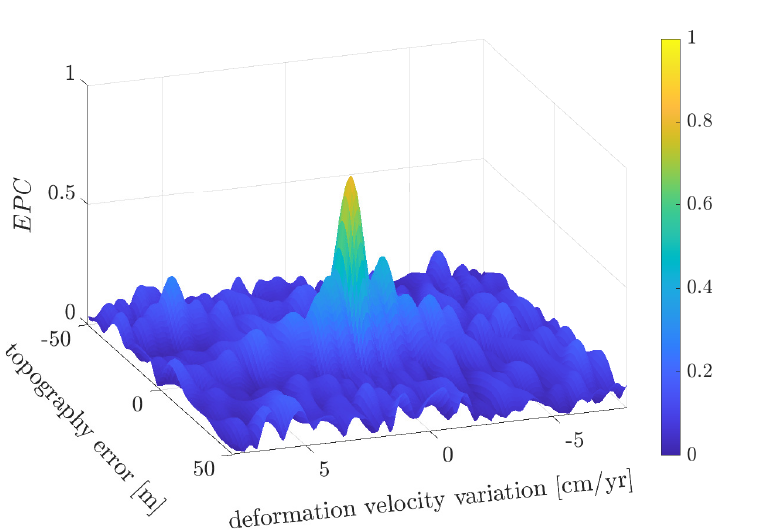
Figure 2. EPC function exemplary for one phase gradient depending on the error of the scene topography and the deformation velocity